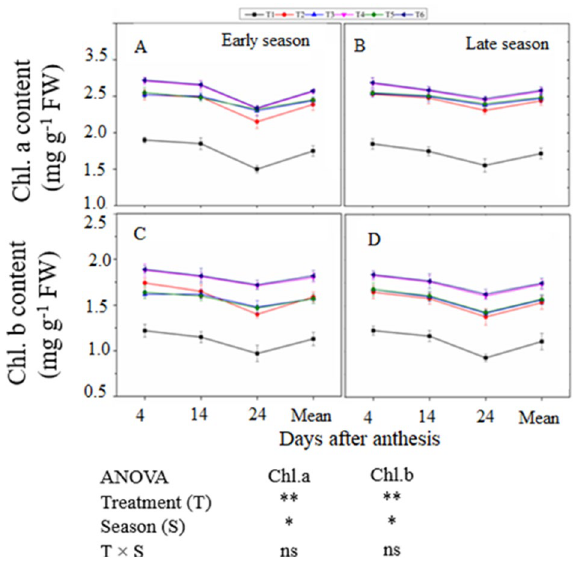
Figure 3. Leaf chlorophyll content a and b at 4, 14, and 24 days after anthesis during grain filling at early ( A , C ) and late ( B , D ) season in response to combined organic and inorganic N fertilization. Vertical bars represent the standard error of means. Different letters above the column indicate significance at ( P < 0.05). Note: Chl.a–Chlorophyll a, Chl.b–Chlorophyll b, FW–Fresh leaf weight. ns: non significant, * p < 0.05, ** p < 0.05. For treatment details please see Table